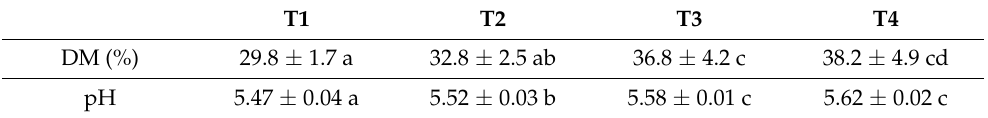
Figure 1. DM evolution with ageing time.